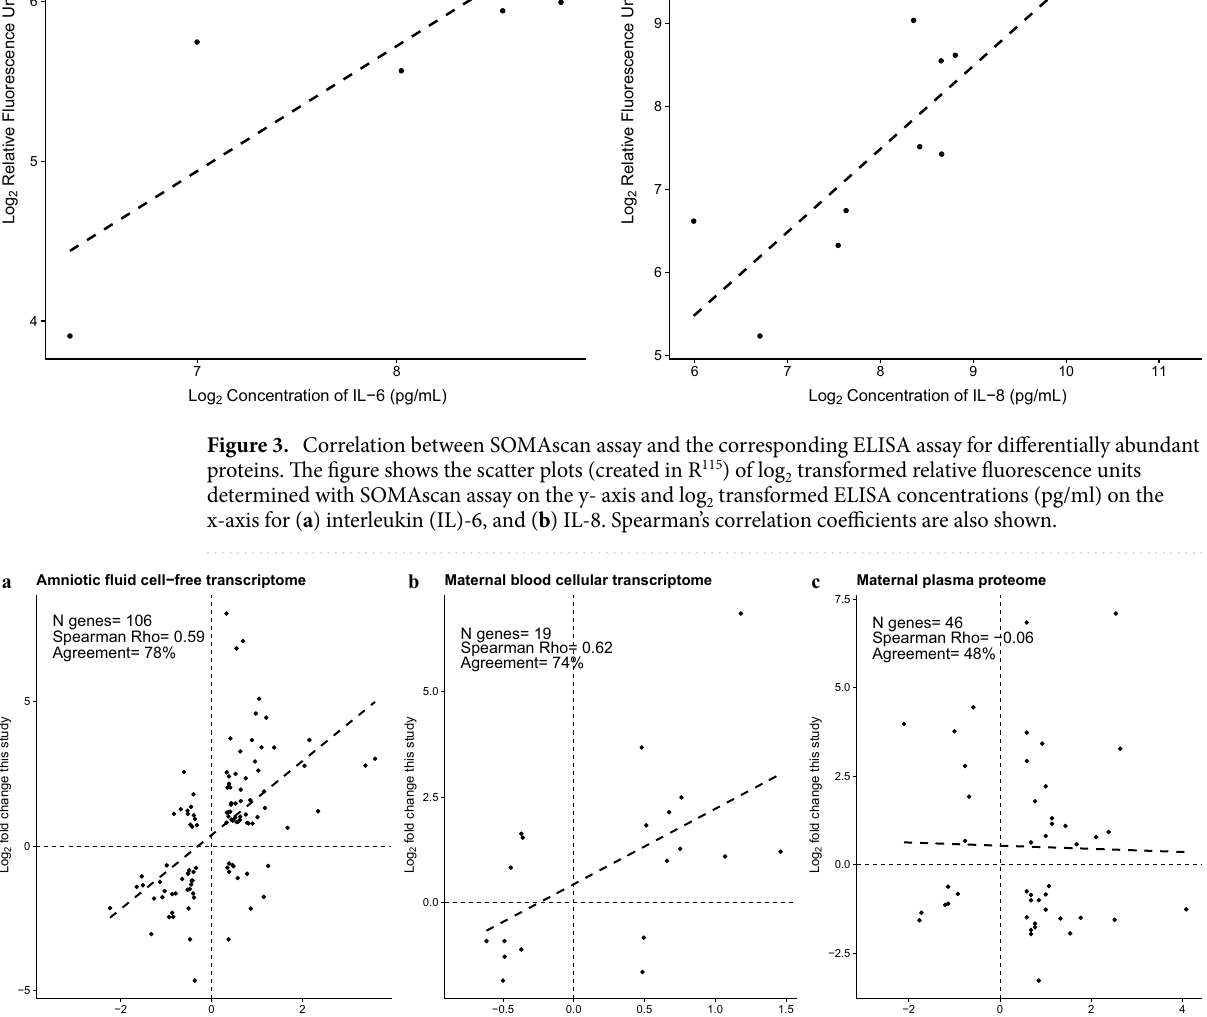
Figure 4. Correlation between gestational age-dependent changes in the amniotic fluid proteome and those previously reported in the cell-free amniotic fluid transcriptome, maternal blood cellular transcriptome, and maternal plasma proteome. Scatter plots (created in R 115 ) show the Spearman’s correlation between log 2 fold changes between the gestational-age groups obtained in this study for amniotic fluid proteins (on the y-axis ) and those previously reported for corresponding proteins or genes (on the x-axis) in ( a ) cell-free amniotic fluid transcriptome, ( b ) maternal blood cellular transcriptome, and ( c ) maternal plasma proteome. For each pairwise comparison, only the molecules (genes/proteins) significant in both studies were included in the correlation